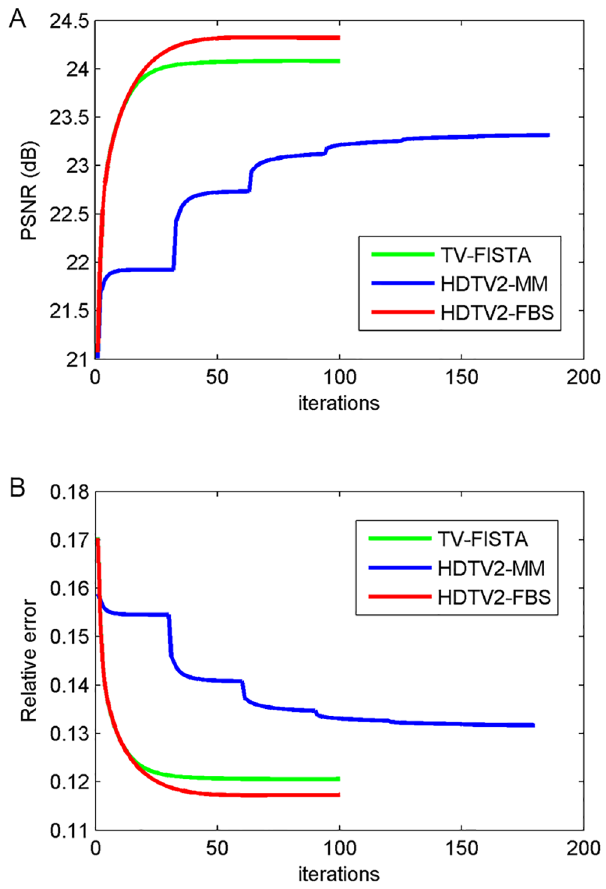
Fig 4. The convergence curve of PSNR and relative error results versus iterations corresponding to the reconstructed example shown in Fig 3. (A) PSNR versus iterations; (B) Relative error versus iterations.